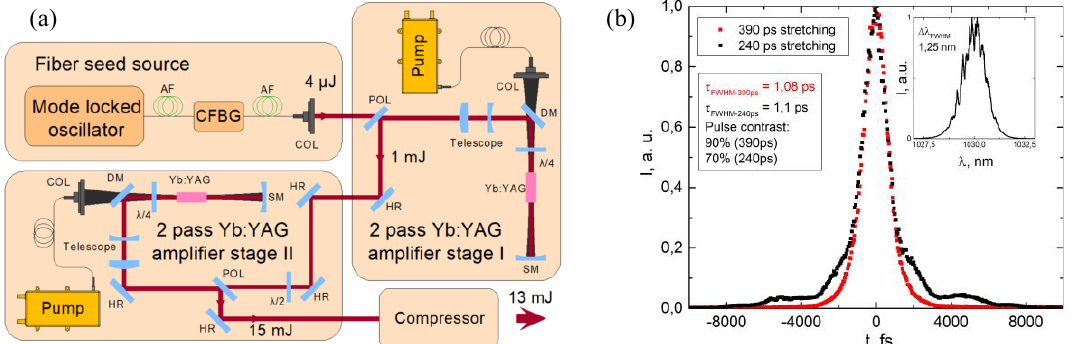
Fig. 1. (a) Schematic representation of 10 mJ, 20 Hz laser system. AF – fiber amplifier, CFBG – chirped fiber Bragg grating, λ/4, λ/2 – quarter-wave and half-wave plates, COL – beam collimator, POL – thin film polarizer, DM – dichroic mirror, SM – spherical mirror, HR – high reflectivity mirror. (b) Intensity autocorrelation of the output pulse at different pulse stretching ratios and pulse spectrum